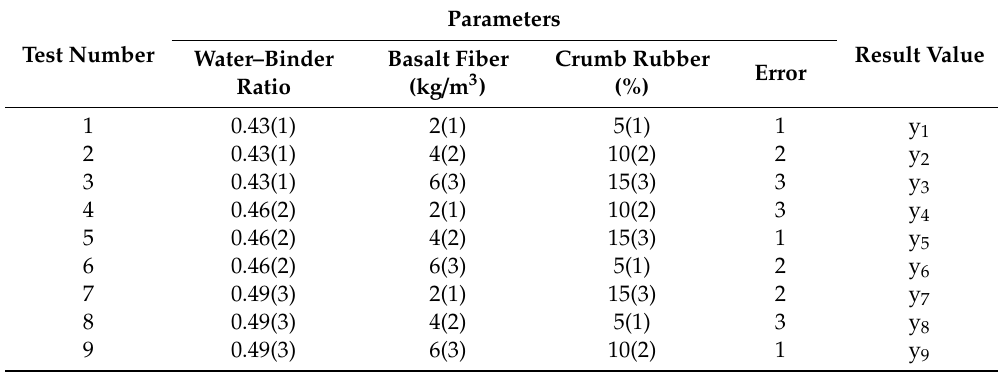
Table 5. Specific orthogonal experimental